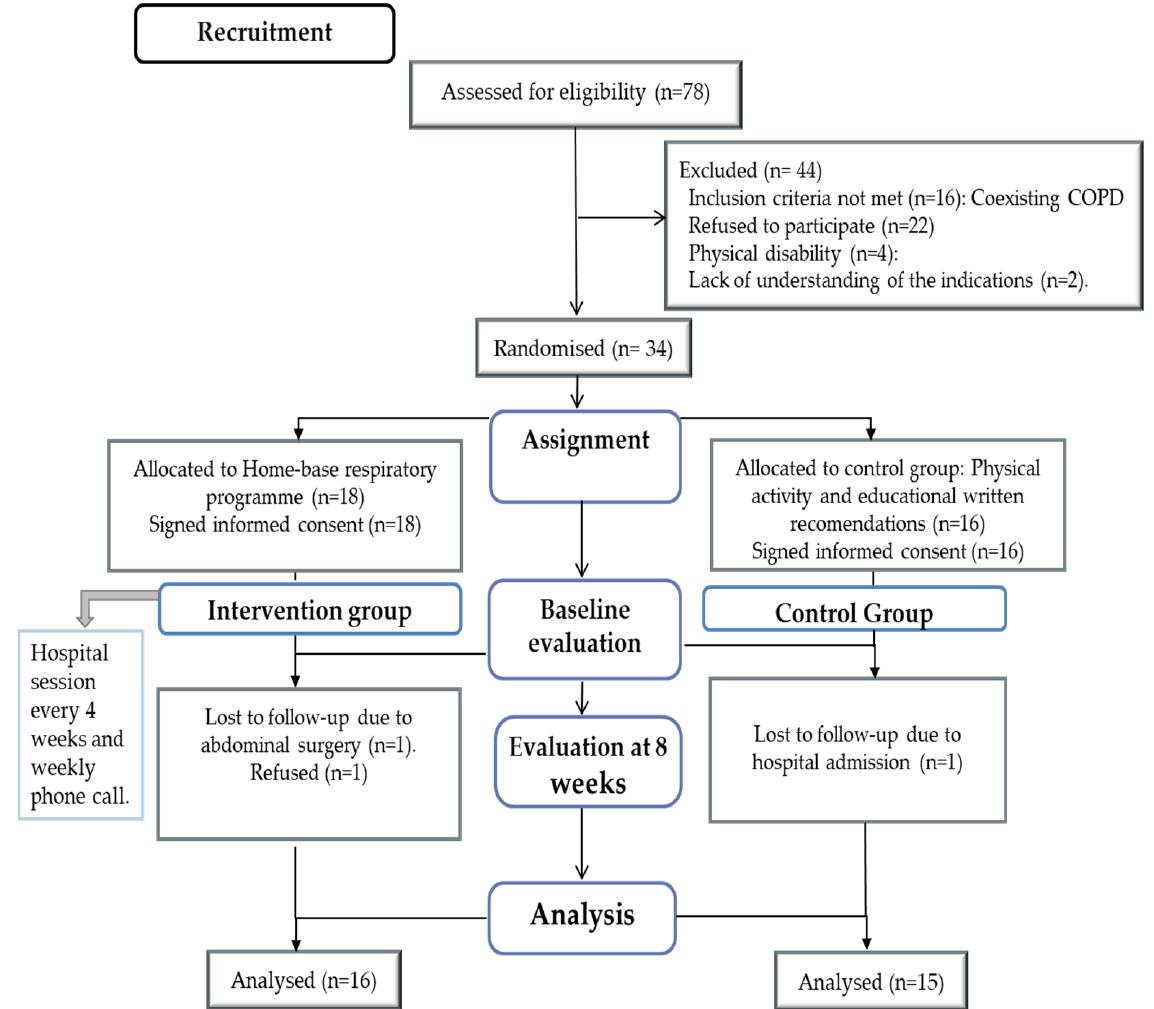
Figure 1. Flowchart of patients.